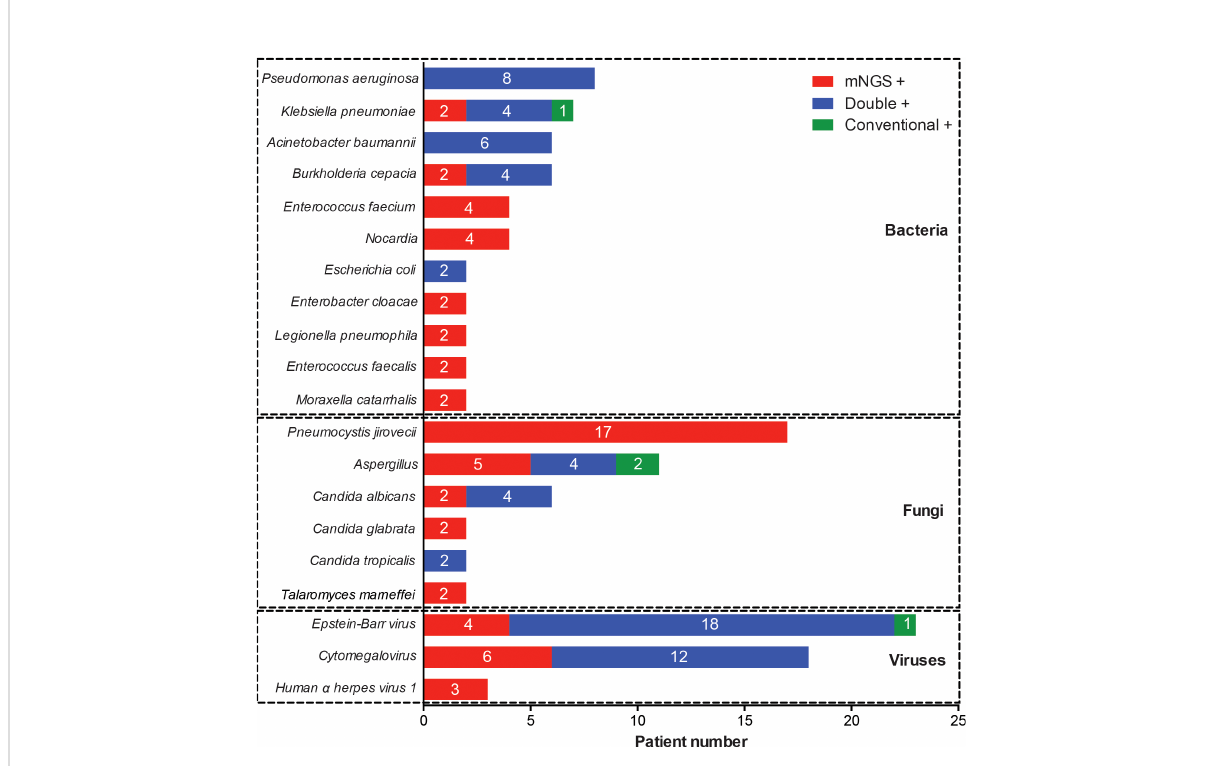
FIGURE 3 Distribution of pathogenic microorganisms detected by mNGS and conventional methods alone or simultaneously.